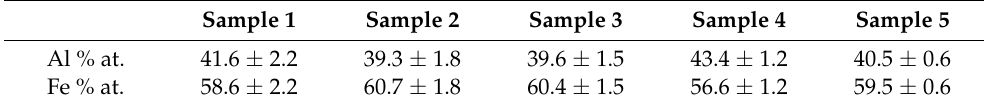
Table 1. EDS analysis of the Fe40Al specimen.